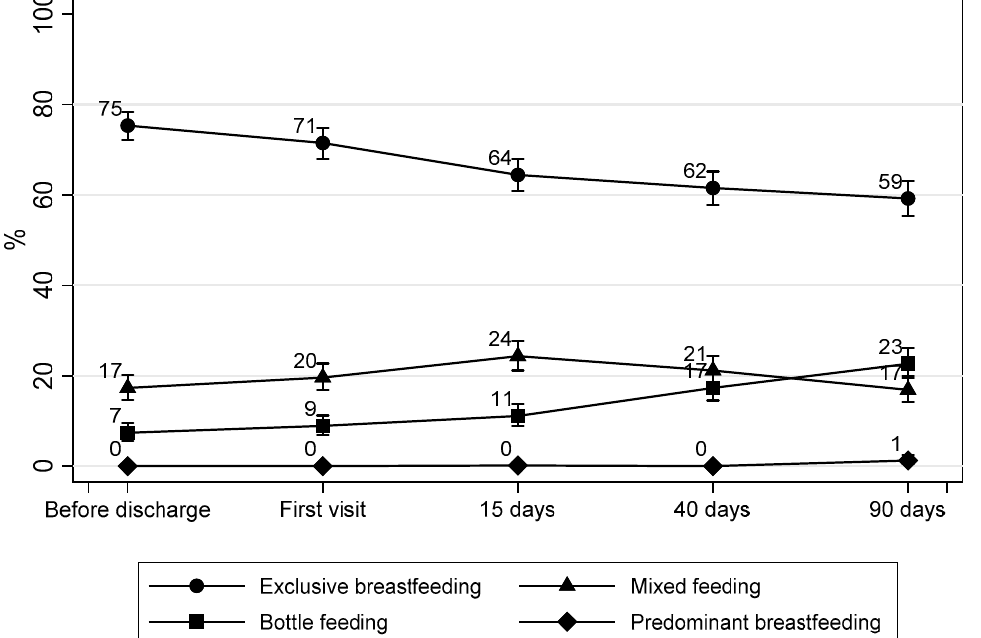
Figure 1. Type of feeding rates during follow-up.